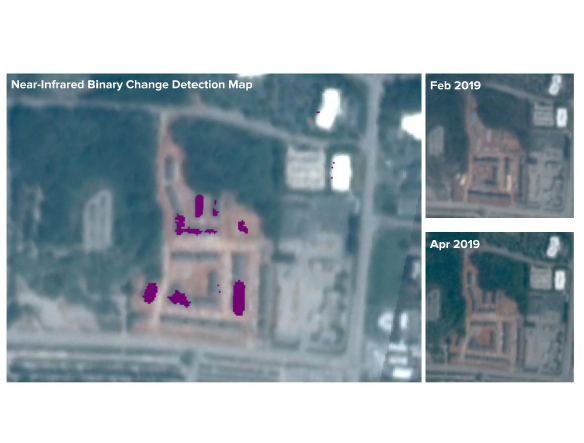
Figure 3: The purple patches in the left image represent the land- cover change (new construction at construction site) detected us- ing binary change detection from image differencing and statis- tical thresholds set to select pixels greater than 3 std between February 2019 and April 2019 in Raleigh, NC using PlanetScope 3m multispectral data.